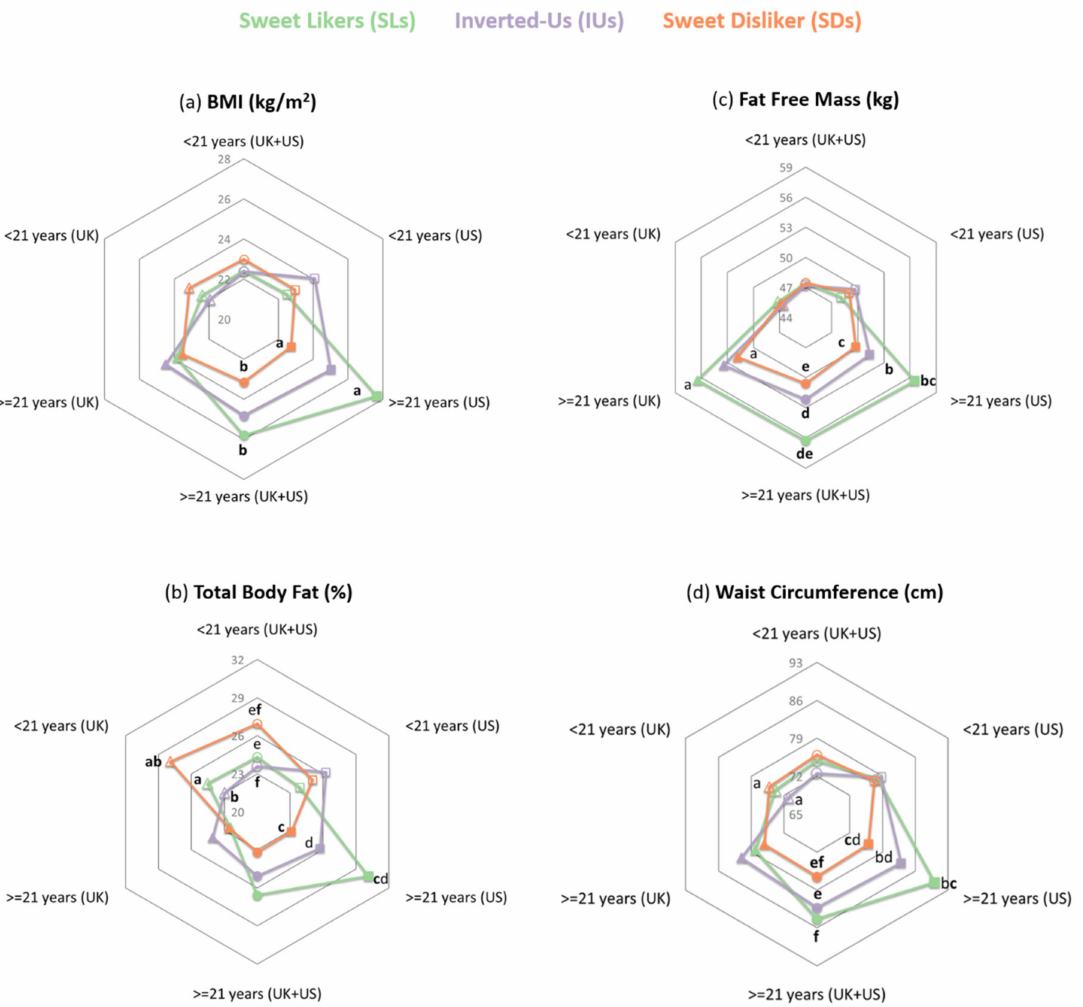
Figure 3. A comparison of the follow-up e ff ects of the sweet liker phenotype on the anthropometric profile for the two cohorts separately and for the sample as a whole (UK + US) plotted by age group. Spider plots show the estimated marginal mean values oF( a ) BMI (kg / m2) and oF( b ) Total Body Fat (%), ( c ) Fat Free Mass (kg), and ( d ) Waist Circumference (cm) adjusted for sex. Examining each spider plot separately, the same letters indicate significant di ff erences ( p < 0.05; bold) or tendencies ( p < 0.075) in the paired post hoc comparisons of the estimated marginal mean values of each anthropometric measure of interest. For example, among participants 21 years old and older of both cohorts (UK + US), sweet dislikers (SDs) had lower BMI (23.1 kg / m 2 ) than sweet likers (SLs) (25.8 kg / m 2 ; p = 0.016), but did not significantly di ff er in their mean BMI values from participants classified into the inverted-U (IU) phenotype (24.8 kg / m 2 ; p = 0.082). For BMI, highlighted p -values correspond to analysis of variance of BMI’s natural logarithm; original BMI values are used for graphical representation only. BMI, body mass